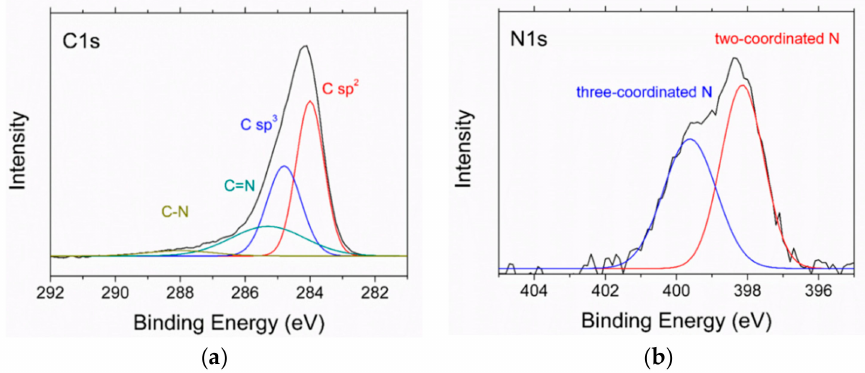
Figure 8. XPS spectra of the N-DLC sample with 2.8 at % nitrogen: ( a ) C1s spectrum; ( b ) N1s spectrum.